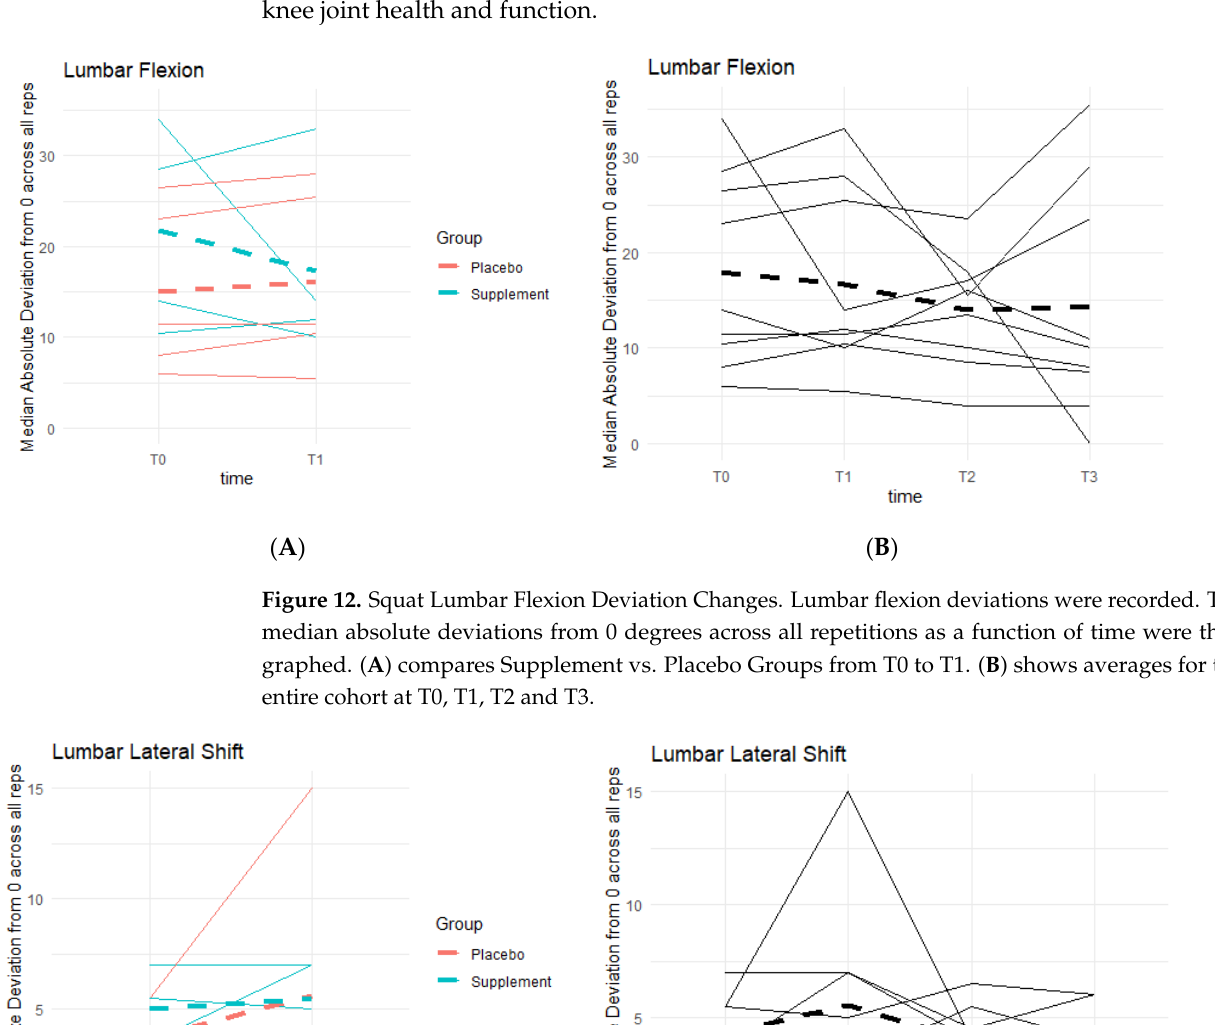
Figure 12. Squat Lumbar Flexion Deviation Changes. Lumbar flexion deviations were recorded. The median absolute deviations from 0 degrees across all repetitions as a function of time were then graphed. ( A ) compares Supplement vs. Placebo Groups from T0 to T1. ( B ) shows averages for the entire cohort at T0, T1, T2 and T3.